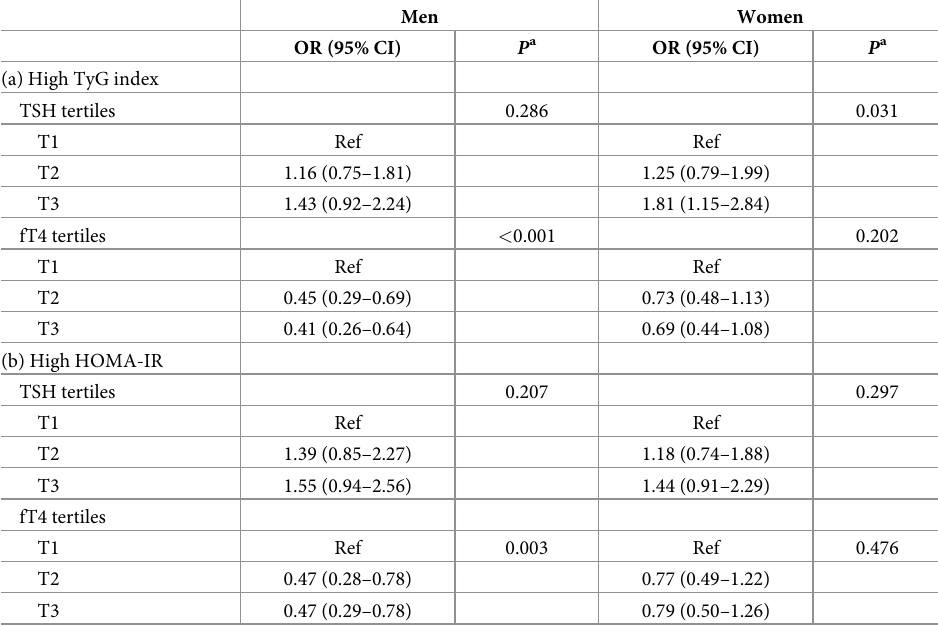
Table 5. Odds ratio for high TyG index and HOMA-IR with respect to TSH or fT4 tertiles by